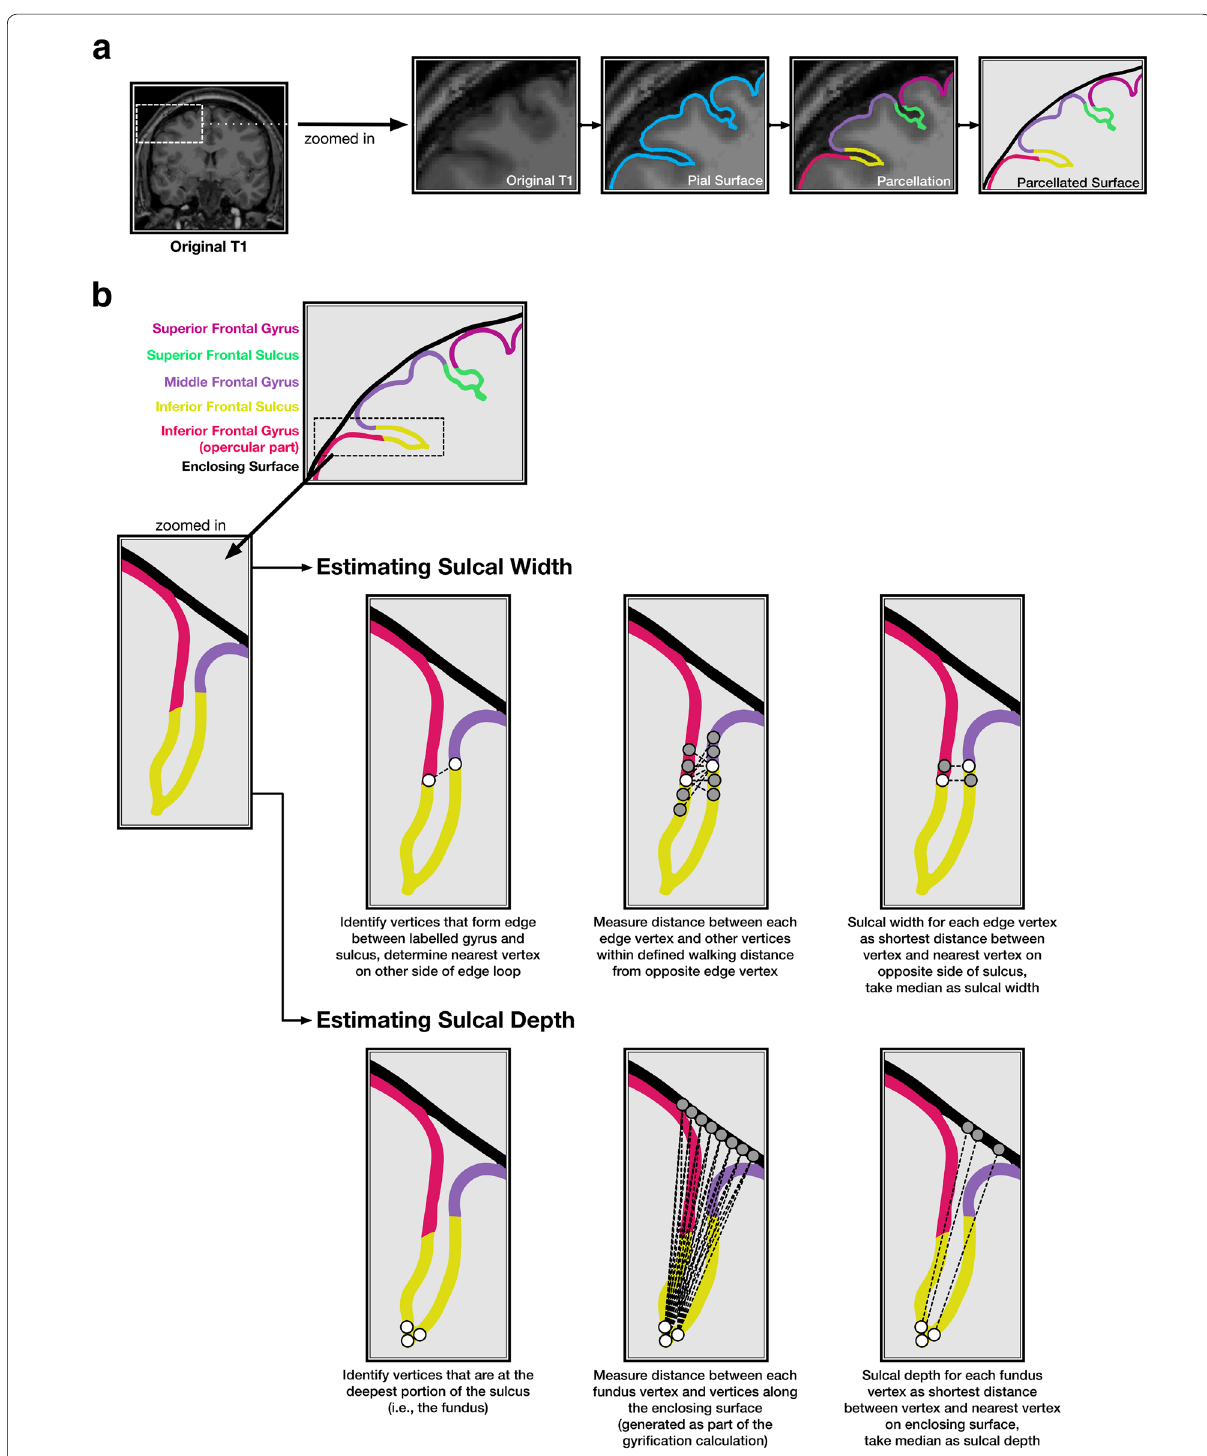
Fig. 4 Illustration of the sulcal morphology method. a Cortical surface estimation and sulcal identification, as output from FreeSurfer. b Sulcal width and depth estimation procedure. Note that the surface mesh and estimation algorithm use many more vertices than shown